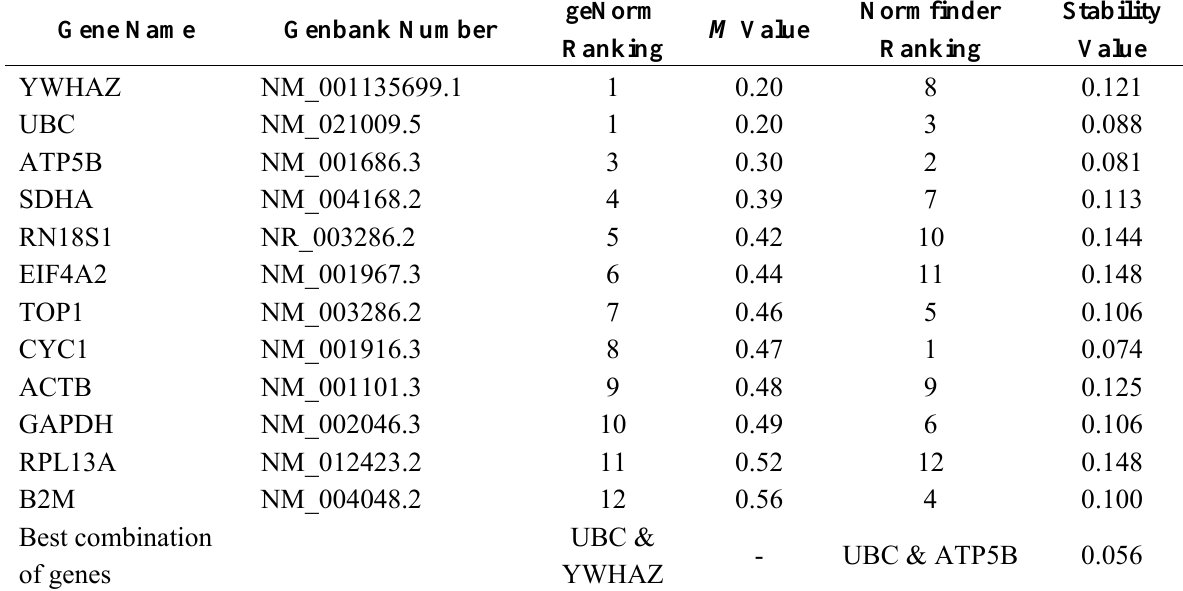
Table 2. Ranking of reference genes in endometrium using the geNorm ( M value) and NormFinder (stability value) algorithms. Lower M or stability value indicates more stable expression and vice versa . Genes highlighted in bold were those ranking consistently in the top half of the table using both